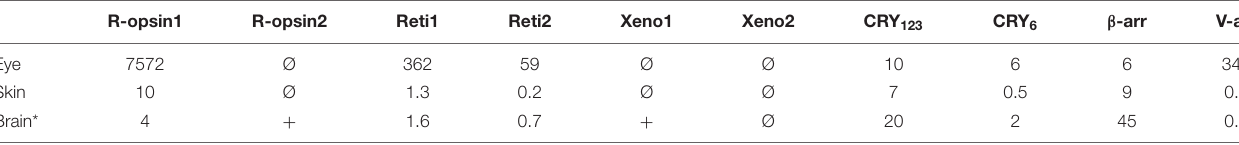
TABLE 2 | Expression of light sensitive molecules in a 1-month old juvenile. R-opsin1 R-opsin2 Reti1 Reti2